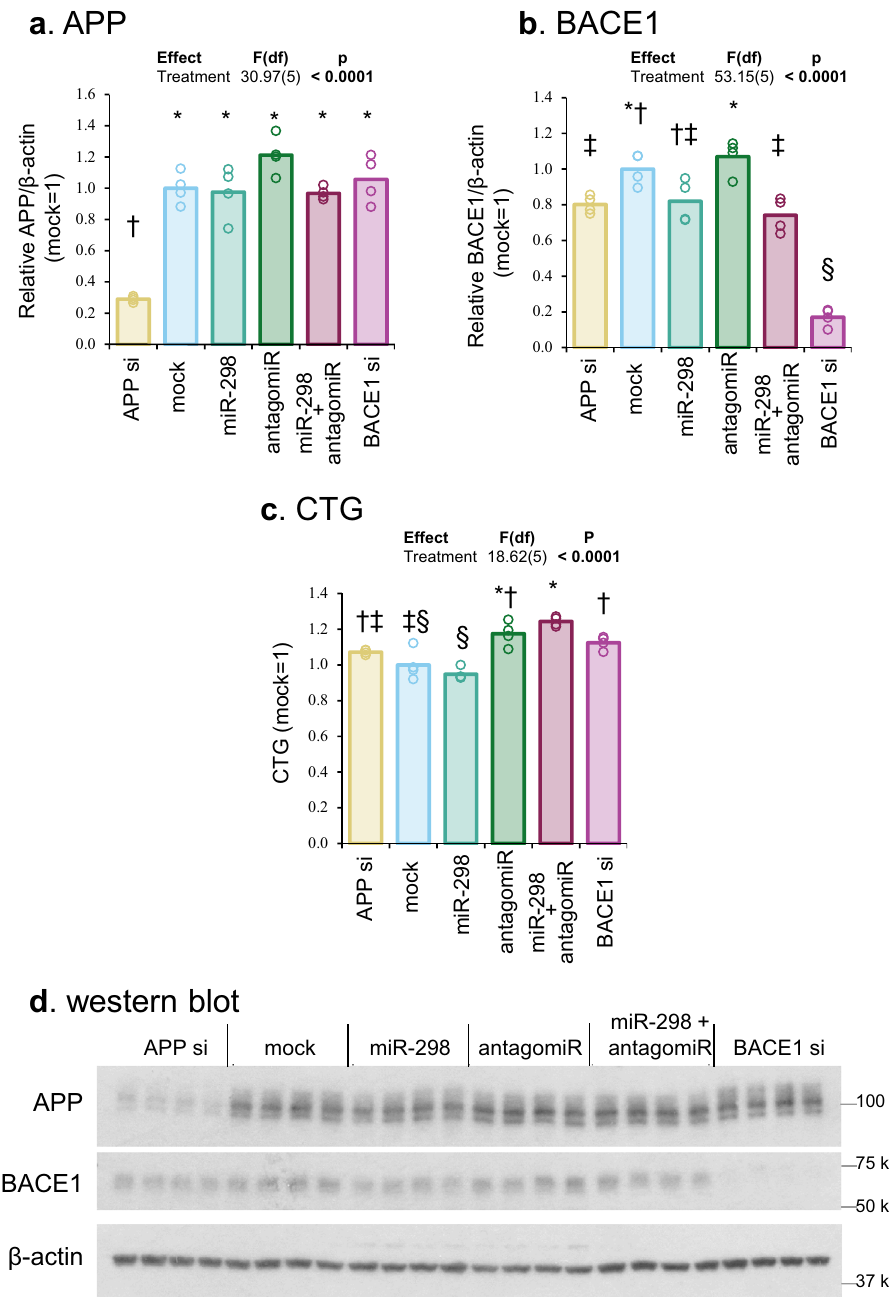
Figure 6. Effects of miR-298 on endogenous APP and BACE1 levels in neural stem cells derived from iPSC. ( a , b ). Densitometric analysis. ( c ) CTG assay. Each symbol represents a different group. ( d ) Western blotting of APP, BACE1, and β-actin. Results of pairwise comparison of all treatments is shown by symbols. Treatments sharing a symbol did not significantly differ (p < 0.05). "(ns)" indicates no significant pairwise